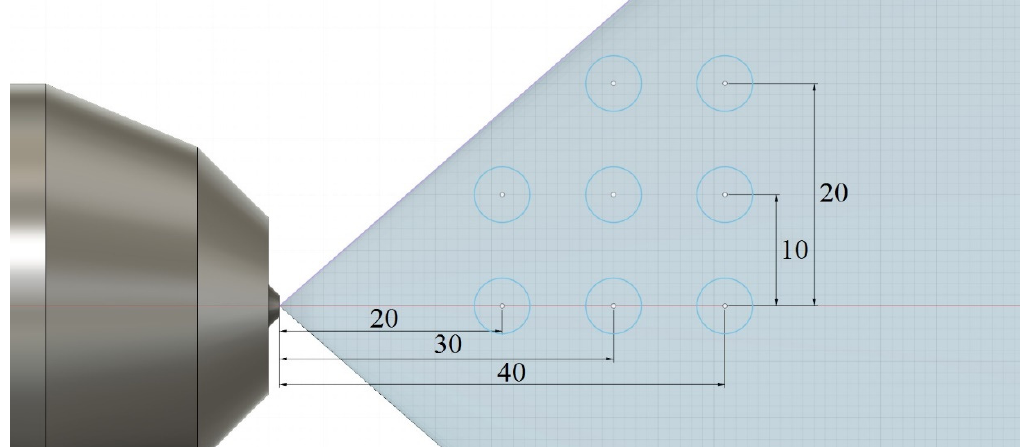
Figure 4. Schematic representation of the measuring positions relative to the spray